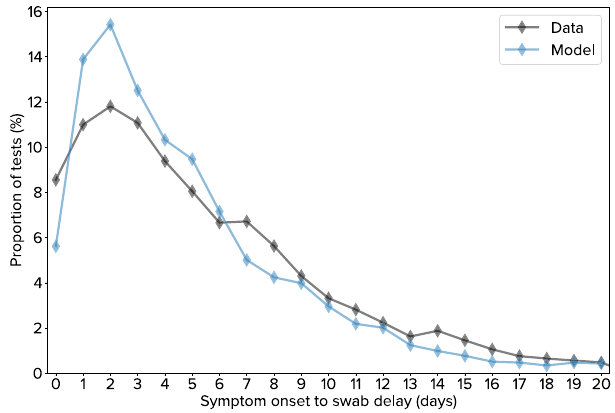
Fig. 6 Delay from COVID-19 symptom onset to nasal swab sample collection. Comparison of empirical (black) and simulated (blue) distributions of